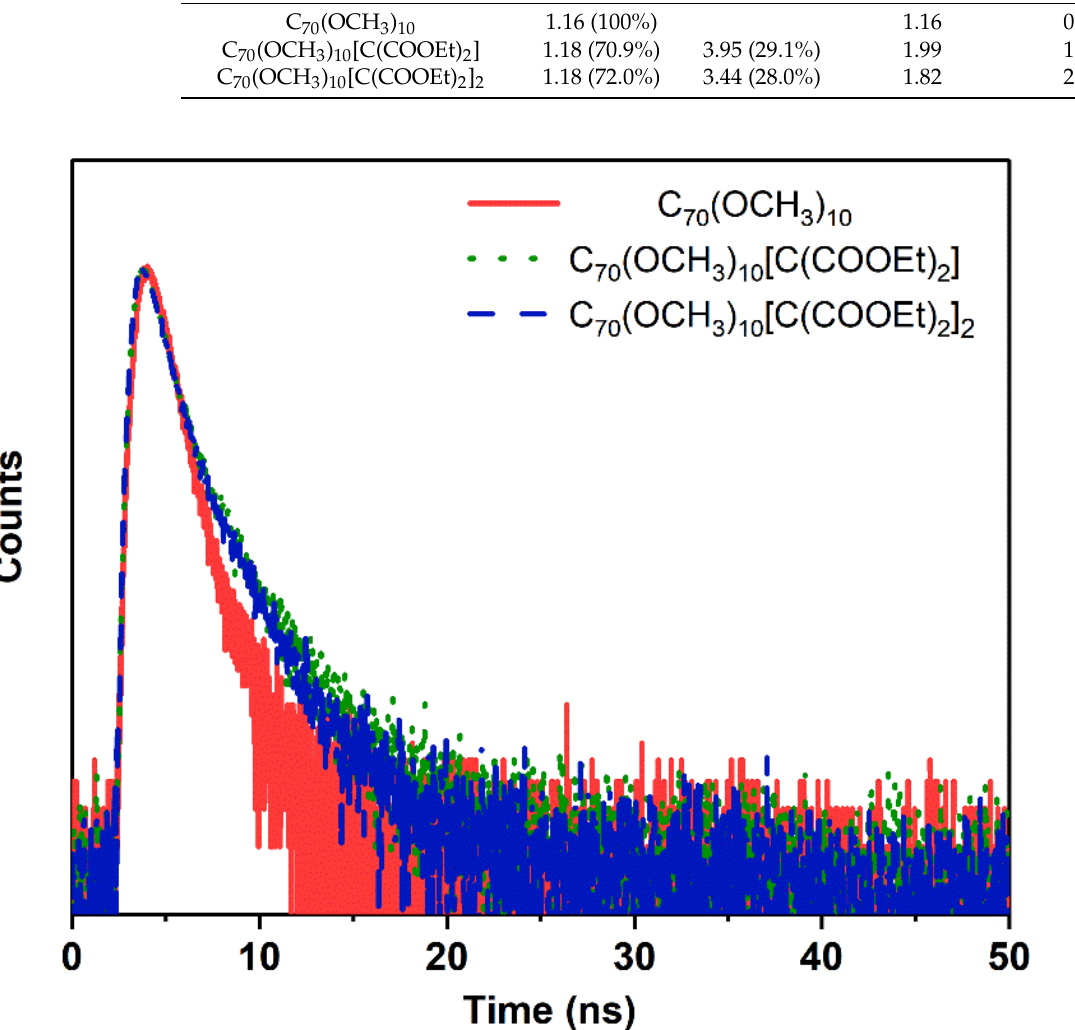
Figure 4. Time-resolved fluorescence decay profiles of C 70 (OCH 3 ) 10 , C 70 (OCH 3 ) 10 [C(COOEt) 2 ], and C 70 (OCH 3 ) 10 [C(COOEt) 2 ] 2 .